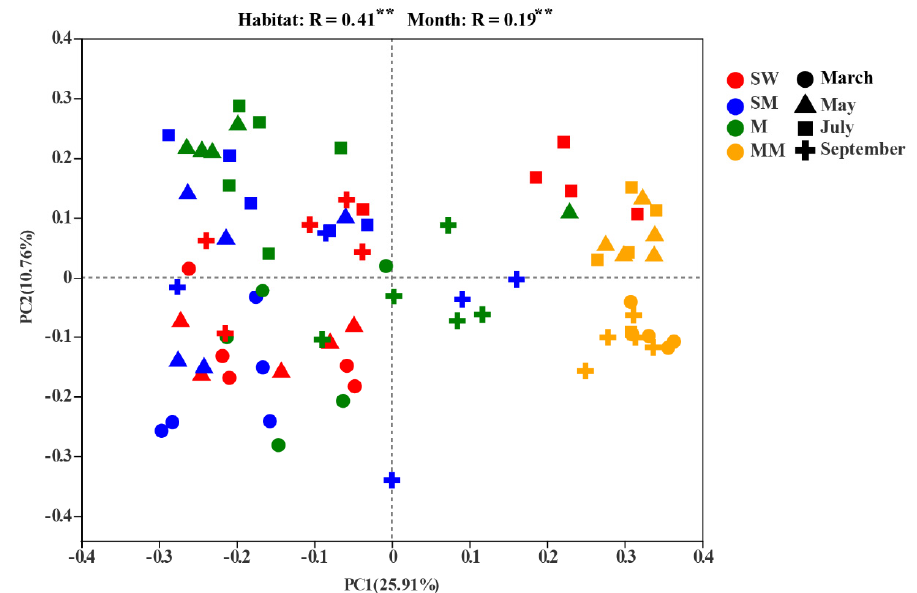
Figure 3. Principal-coordinate analysis (PCoA) plots of bacterial communities in all soil samples. The significant effect of month and habitat on microbial beta diversity was detected by PerMANOVA test. **, p < 0.01. SW is swamp wetland, SM is swamp meadow, M is meadow, MM is mature